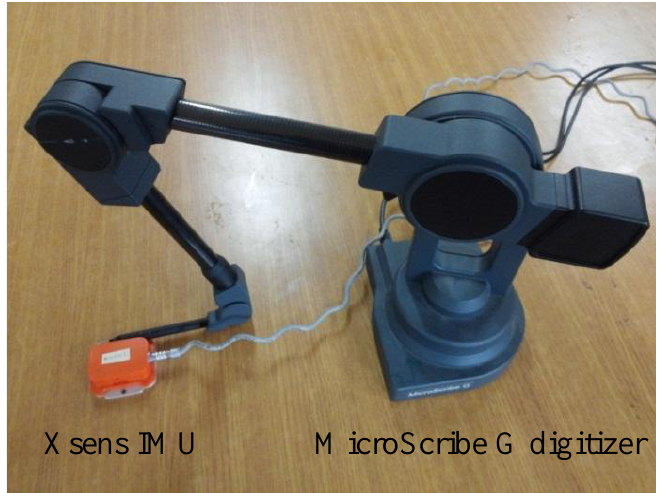
Figure 14. Curve movement experiment